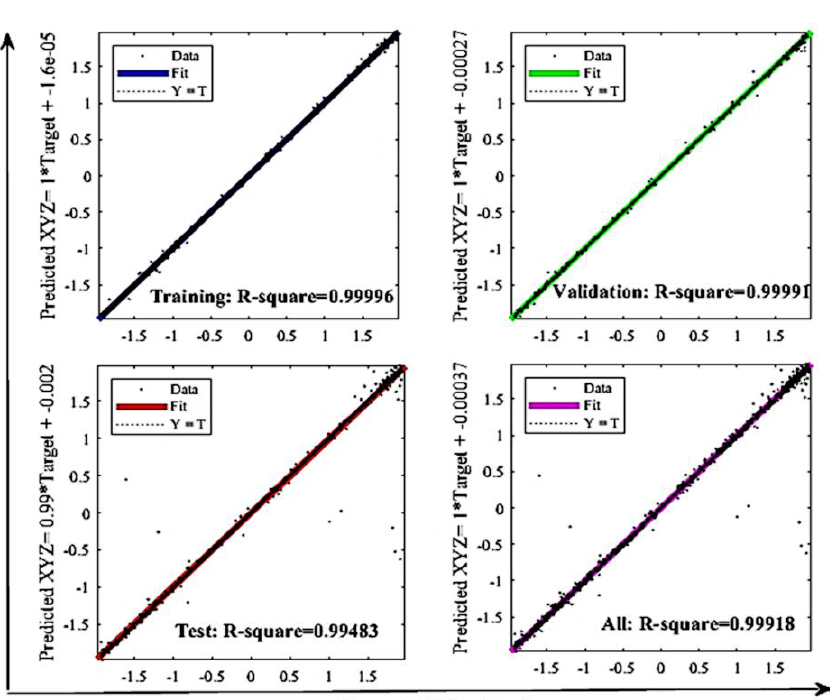
Figure 9. Regression plot of developed